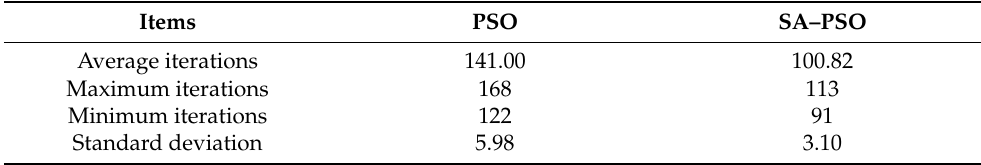
Figure 8. The histogram of iterations for the continuous trajectory. ( a ) Iterations of PSO. ( b ) Itera- tions of SA–PSO. Table 7. The comparison between PSO and SA–PSO in iterations. Table 7. The comparison between PSO and SA–PSO in iterations.